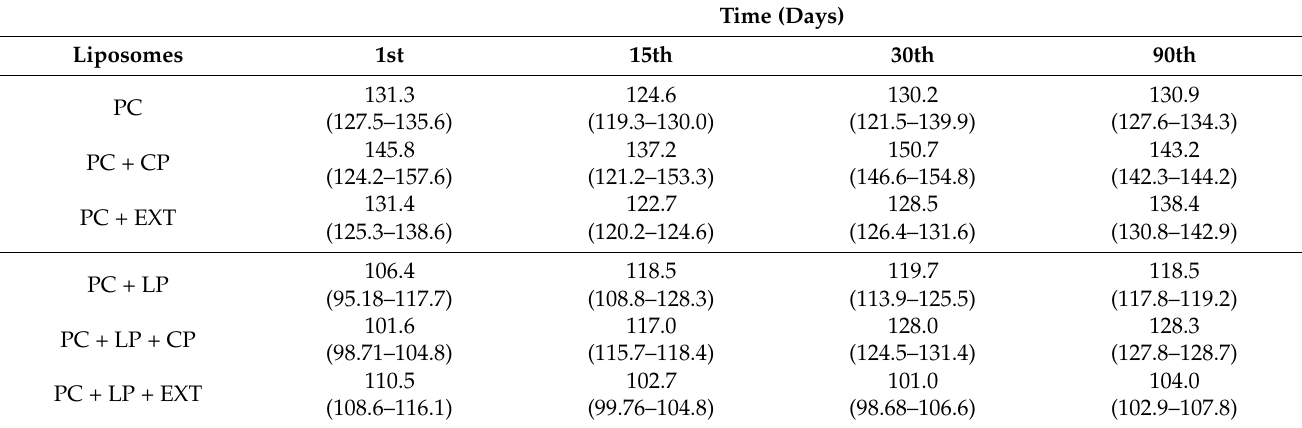
Table 2. Median diameter (nm) of the liposomal dispersion monitored over the course of 90